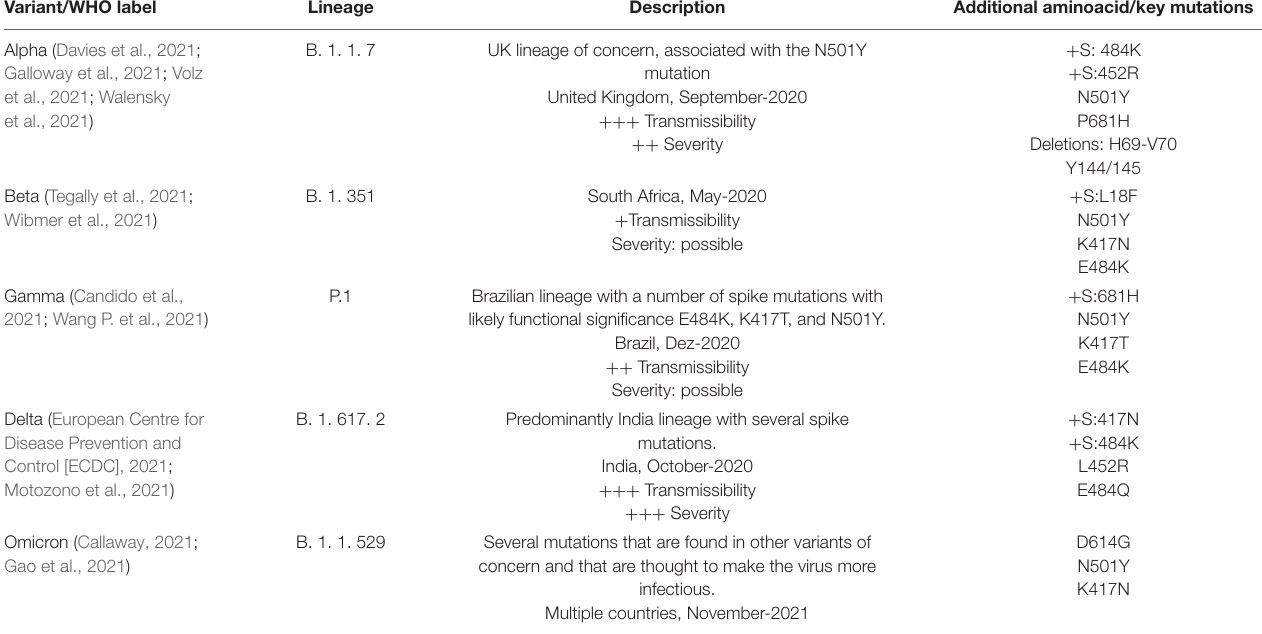
TABLE 2 | Description/features of SARS-CoV-2 variants of